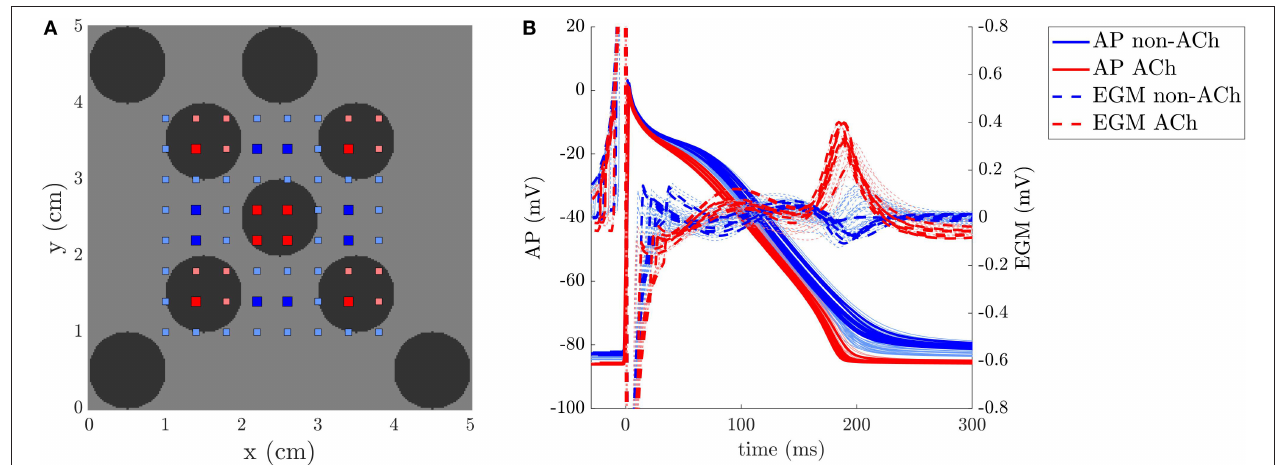
Frontiers in Physiology |